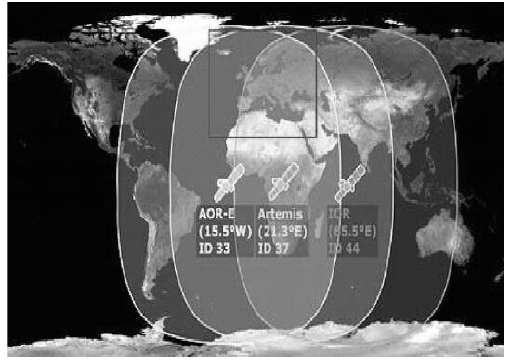
Figure 2. coverage distribution of Gnos